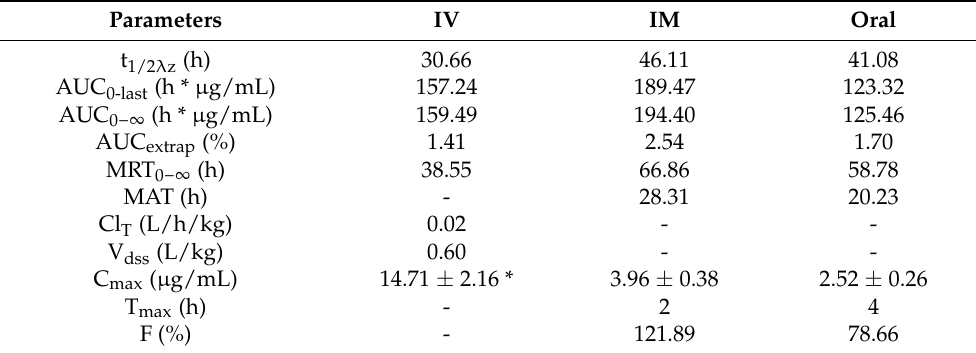
Table 1. Plasma pharmacokinetic parameters of carprofen following intravenous (IV), intramuscular (IM) and oral administrations at a single dose of 2.5 mg/kg in rainbow trout ( Oncorhynchus mykiss ) broodstock at 10 ± 1.5 ◦